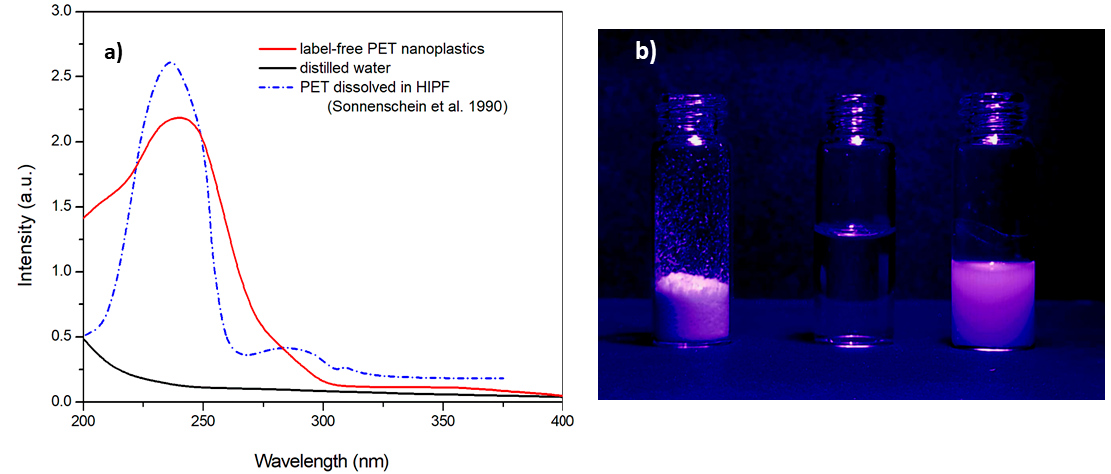
Figure 3. ( a ) UV–Vis absorption spectra of the aqueous dispersion of label-free PET nanoparticles, distilled water, and, for comparison purposes, the references spectrum of PET dissolved in hexafluoroisopropanol (HIPF) reported by Sonnenschein et al. [53]. ( b ) Fluorescence of label-free PET microplastics (left vial) and label-free nanoplastic dispersion (right vial) under UV irradiation at 365 nm (distilled water in the center vial).